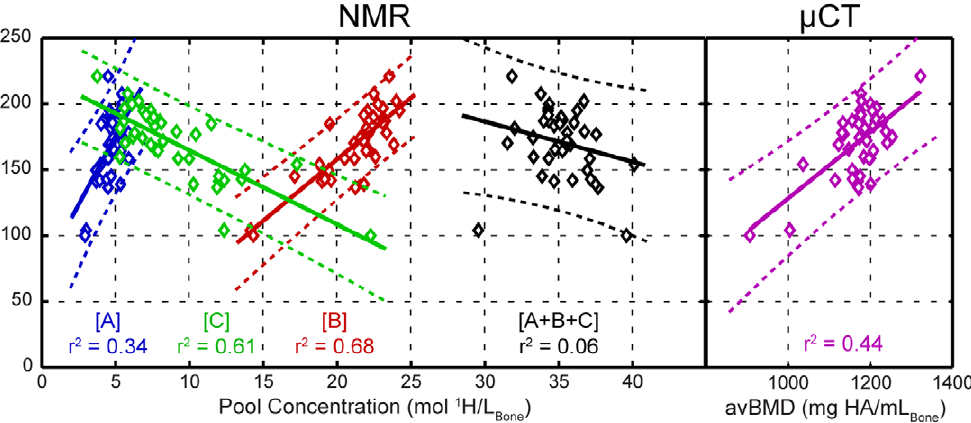
Figure 2. Correlations of measured peak stress and T 2 spectral component amplitudes (NMR, left) and avBMD measured by m CT (right). Blue, red, and green data show integrated amplitudes ( S A , S B , and S C ) of the T 2 -discriminated signals from pools A, B, and C, respectively. The black data show the total 1 H NMR signal ( S A + S B + S C ), and the purple data are derived from m CT-based measures of avBMD. Each of the NMR signals amplitudes shows a significant linear correlation with peak stress and both S B and S C correlate more strongly with peak stress than does avBMD. Note that the total 1 H NMR signal does not correlate well with peak stress.